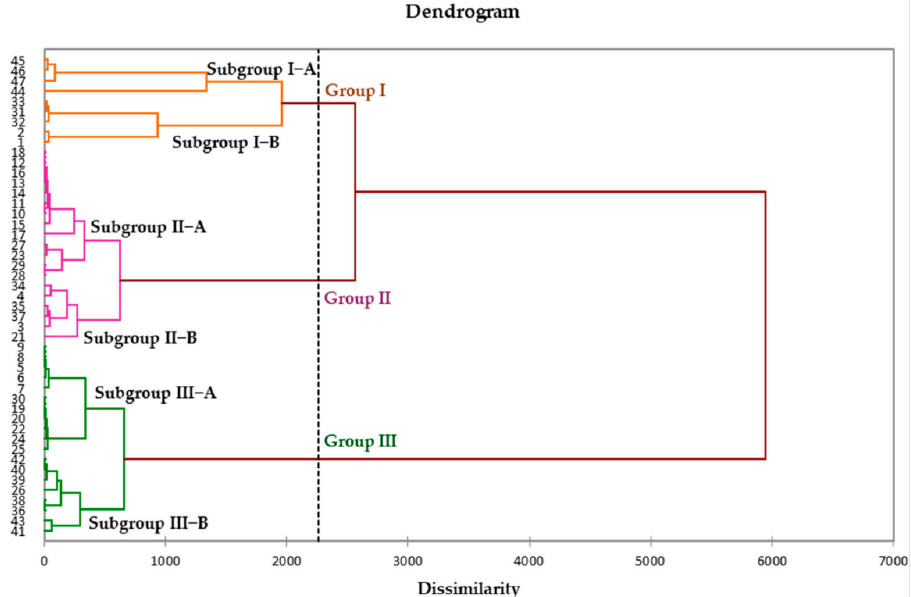
Figure 1. Dendrogram of hierarchical cluster analysis (HCA) of the 47 leaf oil samples from I. dewevrei .